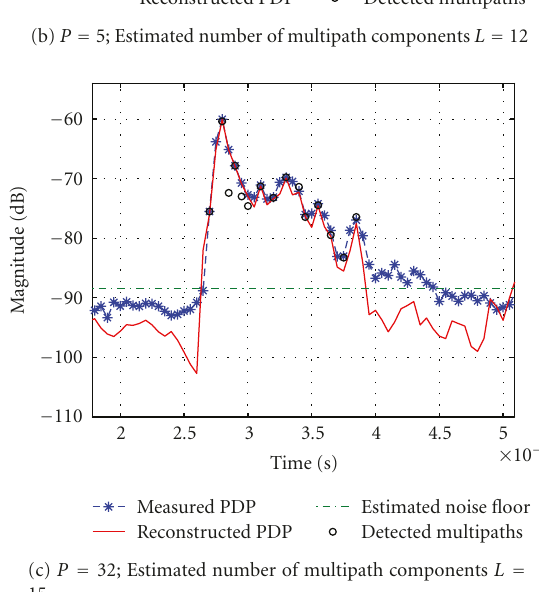
Figure 13: Multipath detection results for quantile-based method with ρ = 1 − 10 − 6